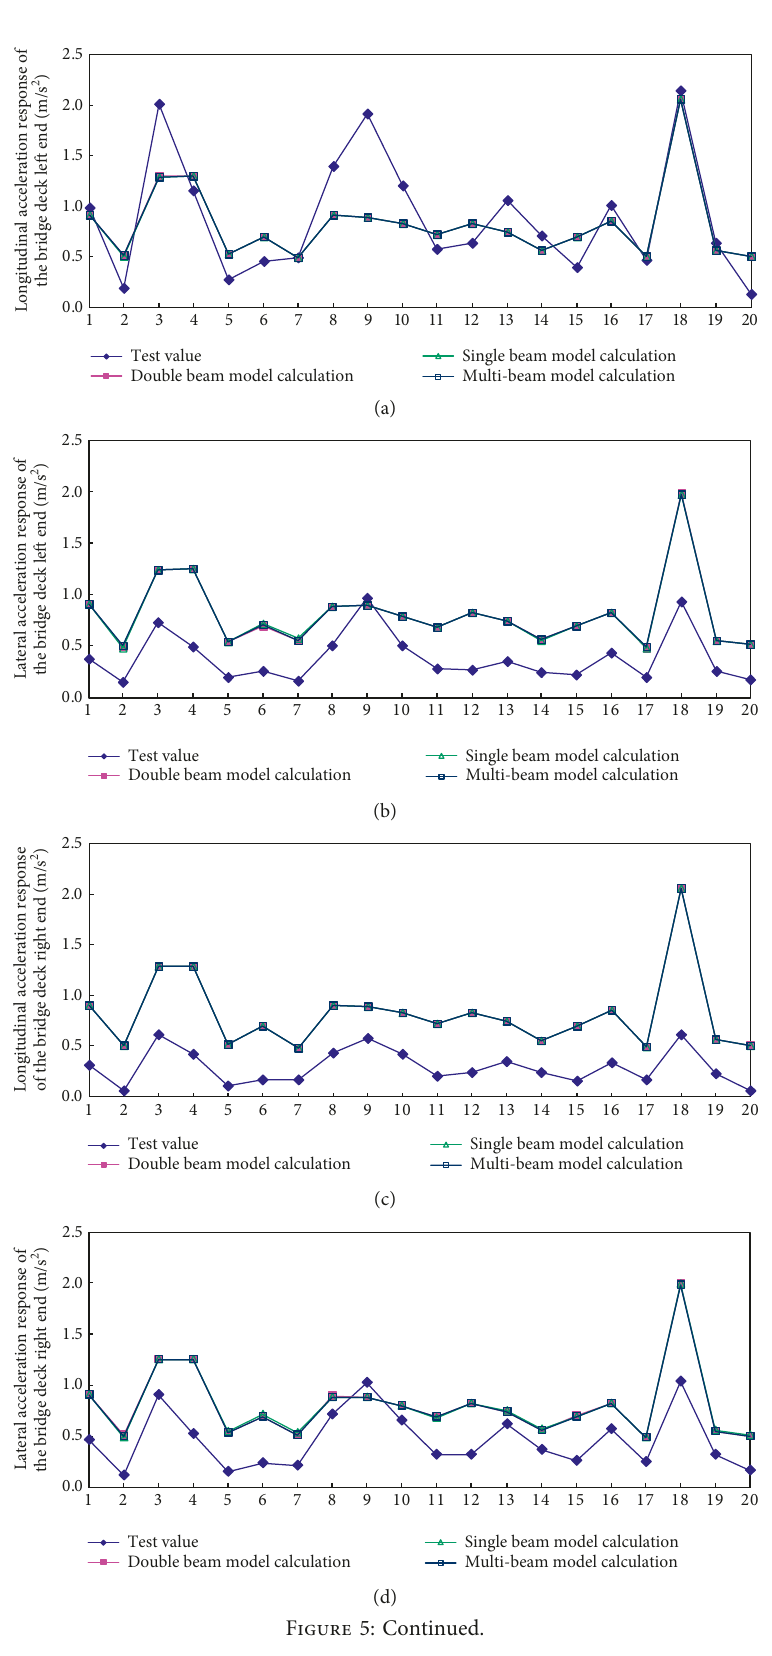
Single beam model calculation Multi-beam model